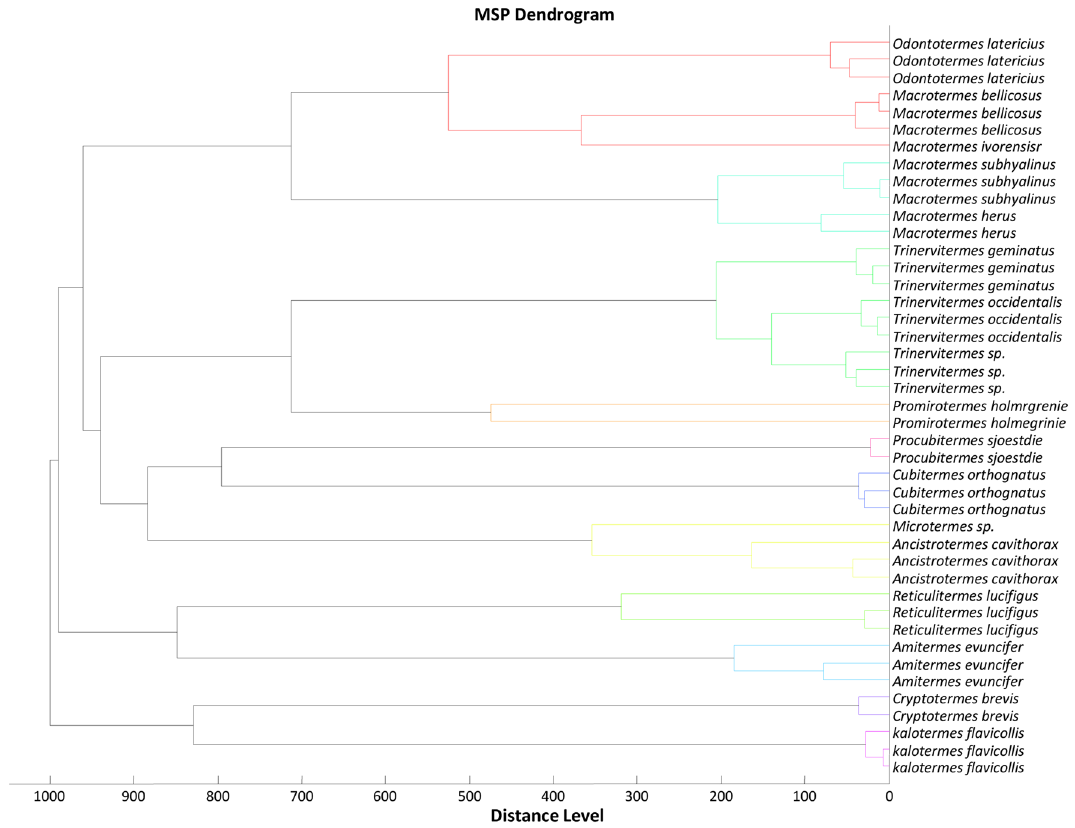
Figure 4. Dendrogram using 2 to 3 representative MS spectra from 16 distinct species treated with Maldi Biotyper v 3.0 software and the distance units correspond to the relative similarity of MS spectra.